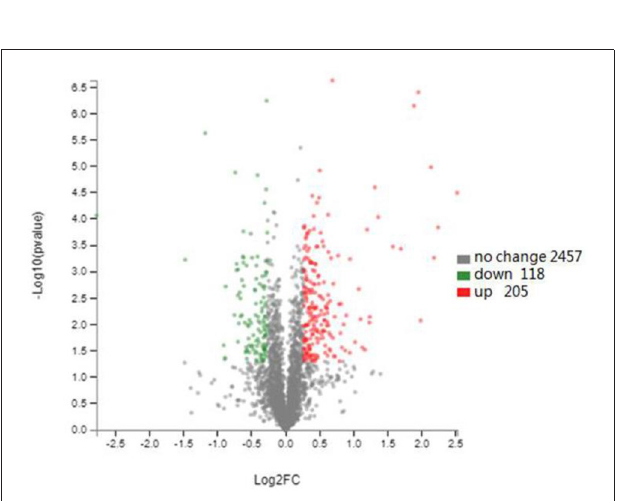
FIGURE 5 | Changes in the E. coli K12 proteome after ybfA deletion. Volcano plots of 2780 identified proteins are shown. The colors indicate the fold changes. Red represents proteins with the fold changes greater than 1.20, and green represents proteins with the fold changes < 0.83 ( P <